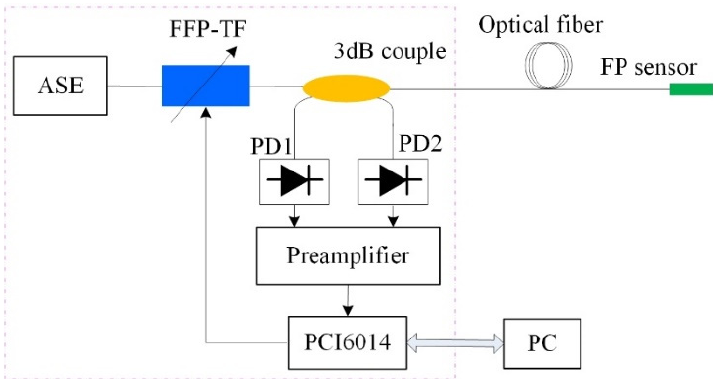
Figure 6. Operating point self-stabilizing system based on an ASE light source and tunable optical- fiber FP